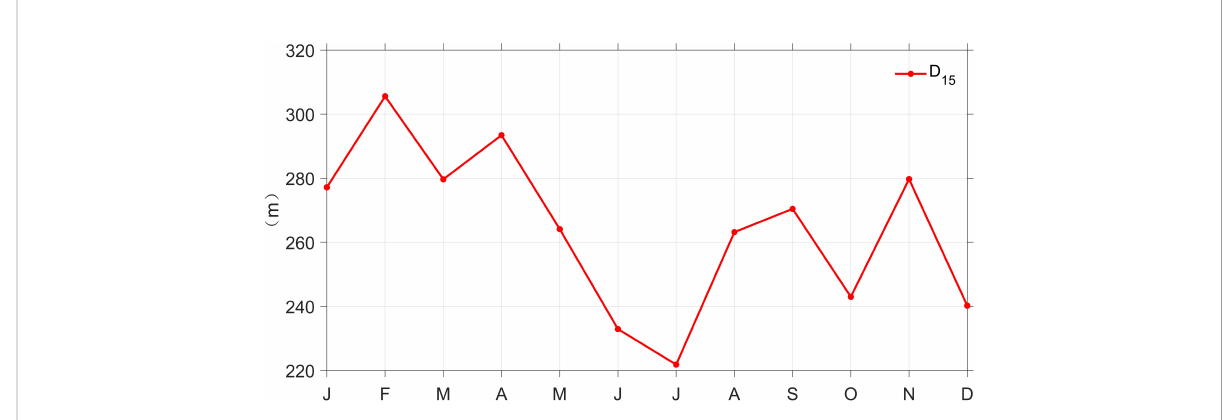
FIGURE 14 Seasonal variation of D 15 along 38°S from OFES during July 1999-October